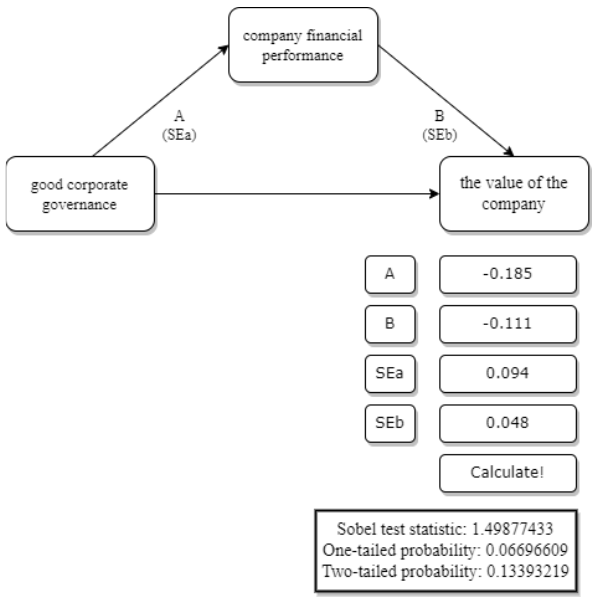
Figure 3 : Sobel Test Results 1; Source: Sobel Test Output Results Version 4.0, 2022.